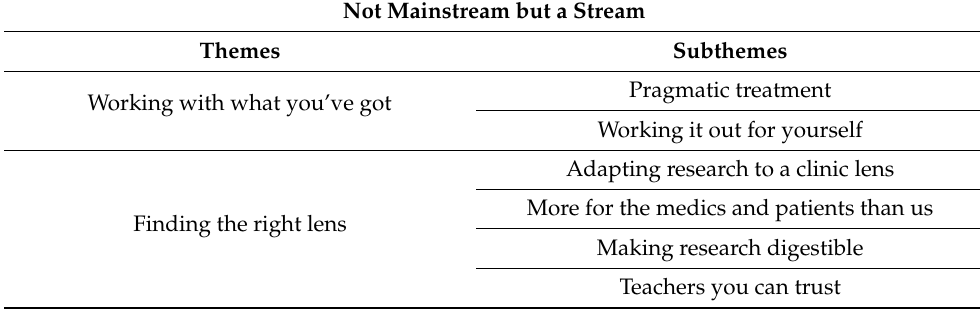
Table 2. Overview of themes and